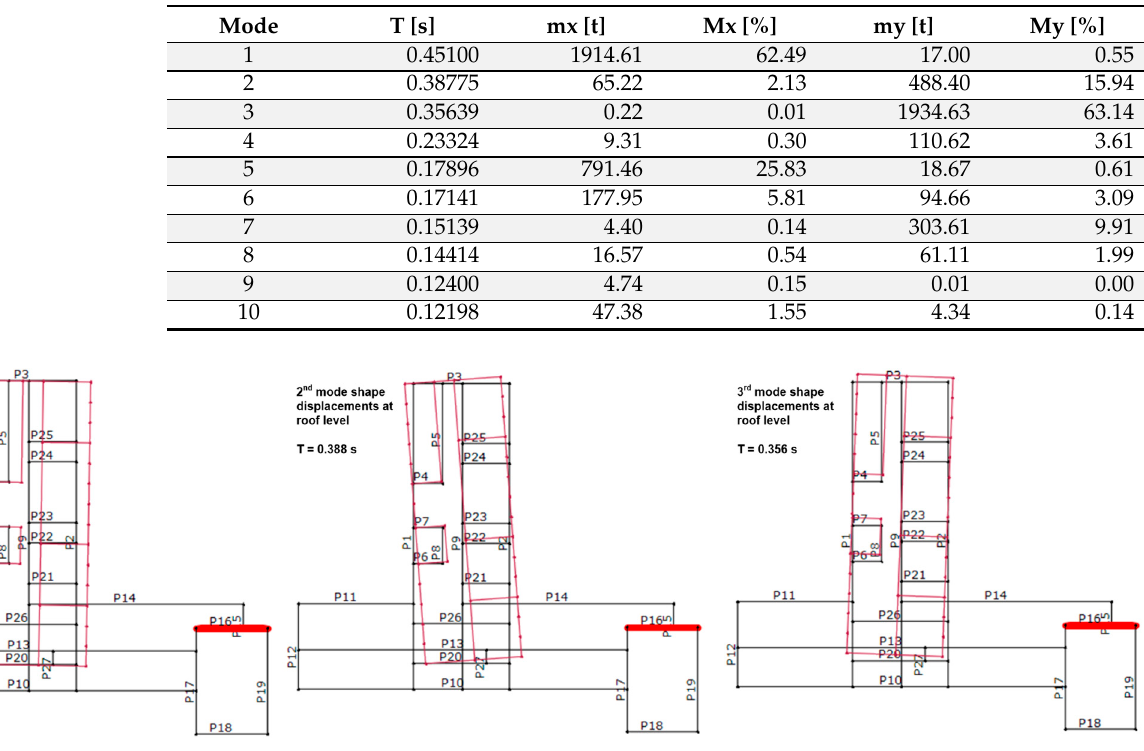
Figure 19. Relevant mode shapes obtained by EFM. Pushover curves were obtained separately for each horizontal direction, considering both positive and negative directions of loading and the eccentricity option. The final failure mechanism of the building is presented for the relevant analysis.